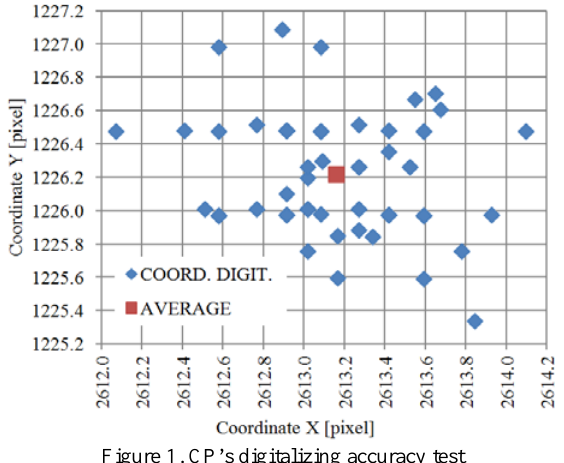
Figure 1. CP’s digitalizing accuracy